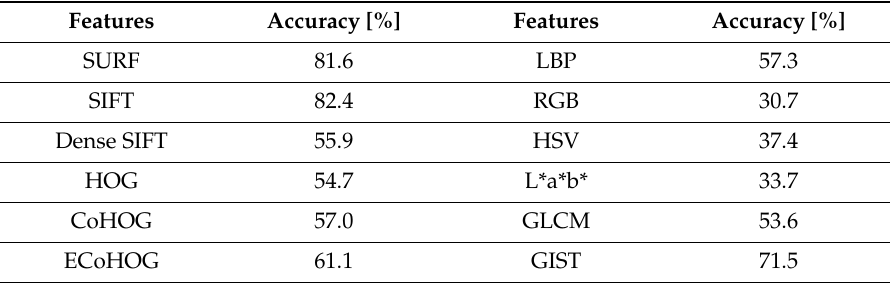
Table 2. Result of conventional classification. Speeded-up robust features (SURF); histogram of oriented gradient (HOG); co-occurrence HOG (CoHOG); extended CoHOG (ECoHOG); local binary pattern (LBP); red, green, blue (RGB); hue, saturation, value (HSV); gray level co-occurrence matrix (GLCM); GIST.